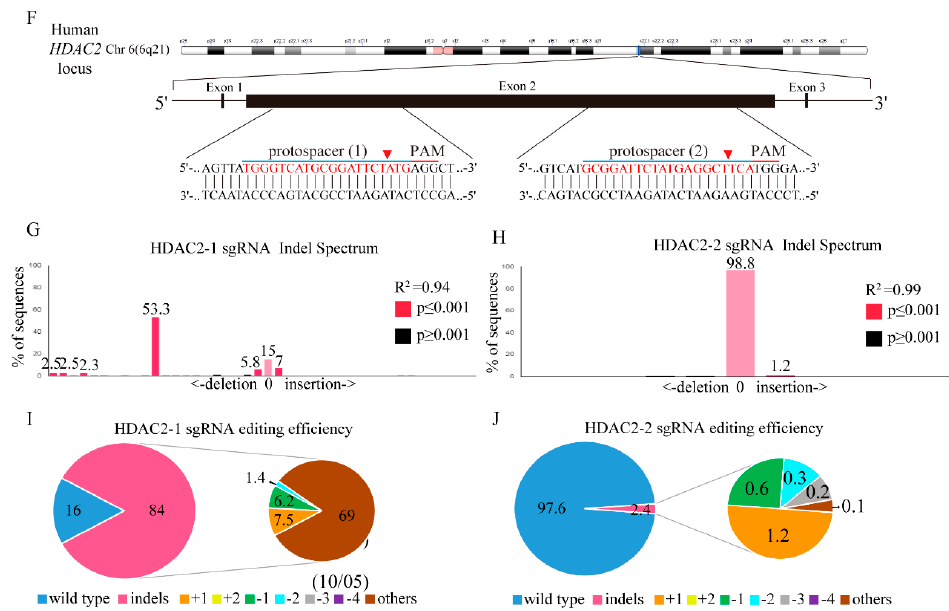
Figure 5. HDAC1 and HDAC2 gene editing in K562 cells using the CRISPR / Cas9 system. ( A ) Schematic representation of the human HDAC1 DNA locus and two protospacer sequences (blue underline) for editing. The arrowhead indicates the expected Cas9 cleavage site. The protospacer adjacent motif (PAM, red underline) is the motif required for Cas9 nuclease activity. Scrambled (SC) and HDAC1 gene-edited cells were delivered to K562 cells by lentivirus. After transduction, DNA from virus-infected cells was purified and subjected to Sanger sequencing of HDAC1 exon 2. The TIDE algorithm analysis is shown for ( B ) HDAC1 -1 and ( C ) HDAC1 -2 gene-edited virus transfected into K562 cells compared to SC K562 cells. The pie charts show the percentages of indels in the HDAC1 gene edited by ( D ) HDAC1 -1 and ( E ) HDAC1 -2 gene-edited lentivirus. The gene editing e ffi ciency of the two-gene edited virus introduced cells is presented in pink, while the two most common other mutations and + 1 are presented in brown and yellow colors, respectively. ( F ) Schematic representation of the human HDAC2 DNA locus and two protospacer sequences (blue underline) for editing, and PAM sequences for Cas9 recognition (red underline). The arrowhead indicates the expected Cas9 cleavage site. PAM is the motif required for Cas9 nuclease activity. SC- and HDAC2 -edited cells were delivered to K562 cells by lentivirus. After transduction, DNA from virus-infected cells was purified and subjected to Sanger sequencing of HDAC2 exon 2. The TIDE algorithm analysis is shown for ( G ) HDAC2 -1 and ( H ) HDAC2 -2 gene-edited cells virus transfected into K562 cells compared to SC K562 cells. The pie charts show the percentages of indels in the HDAC2 gene edited by ( I ) HDAC2 -1 and ( J ) HDAC2 -2 gene-edited lentivirus. The gene editing e ffi ciency of the two gene-edited cells is presented in pink, while the two most common other mutations and + 1 are presented in brown and yellow